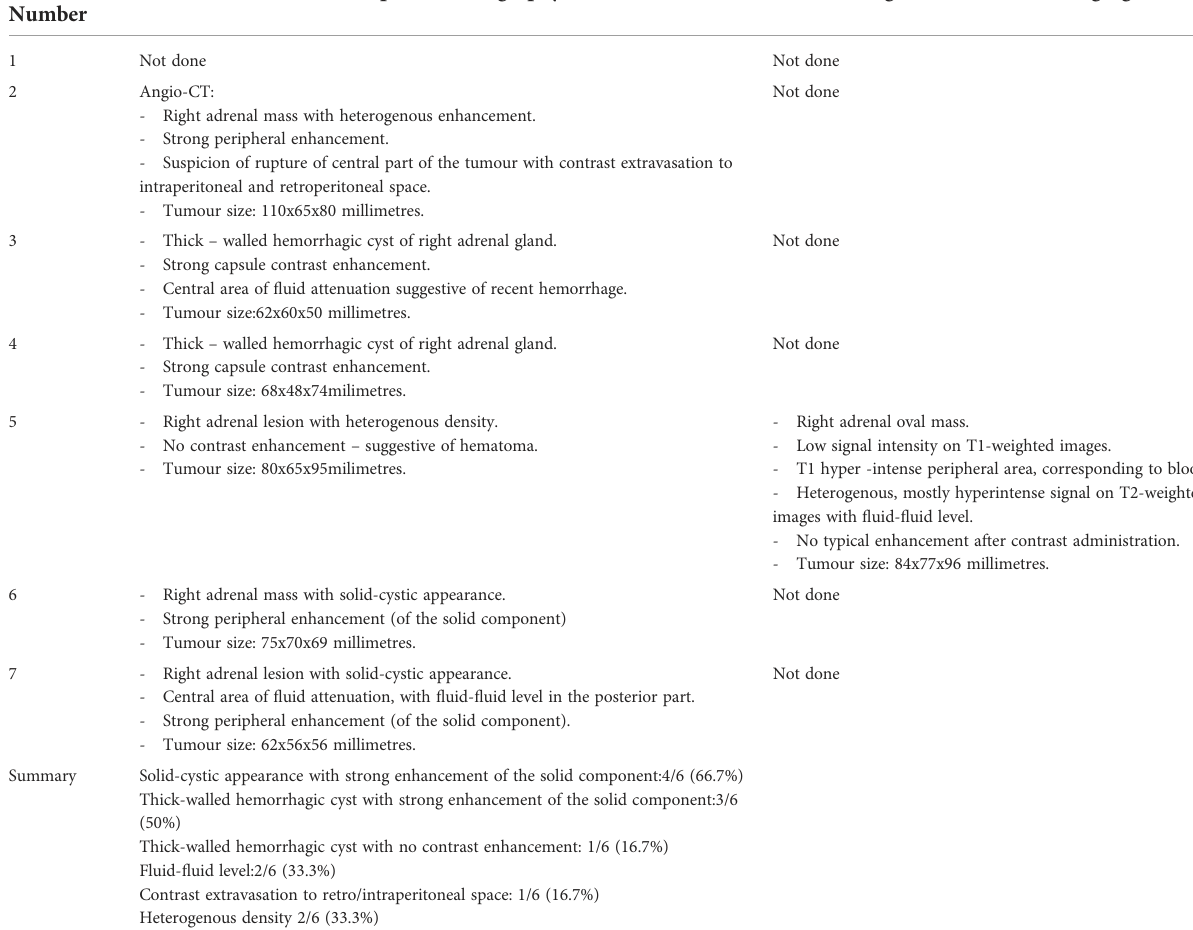
TABLE 2 Summary of the results of Computed Tomography (CT) and Magnetic Resonance Imaging (MRI) in six out of seven patients. Patient ’ s Computed Tomography Magnetic Resonance Number